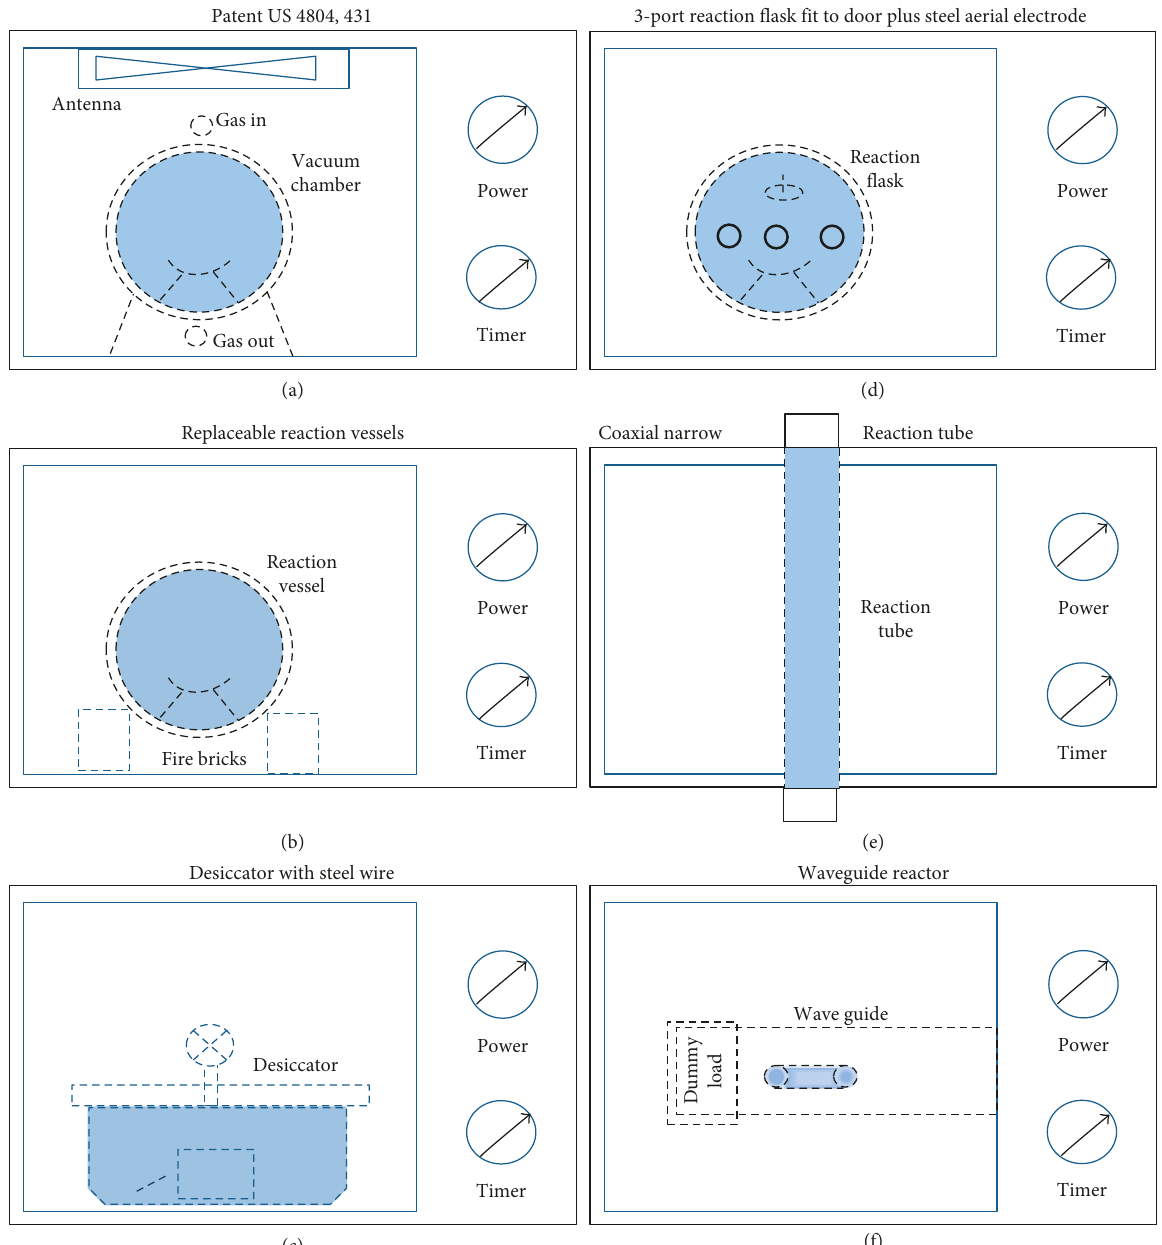
Figure 1: Front view schematic of converted microwave ovens. Each oven is scaled to the US 4,804,431 patent oven, and for clarity, the auxiliary gas lines and vacuum systems outside the ovens are not shown. (a) Patent US 4,804, 431. (b) Replaceable reaction vessels. (c) Desiccator with a steel wire. (d) Three-port reaction flask fitted to door plus steel aerial electrode. (e) Coaxial narrow reaction tube. (f) Waveguide